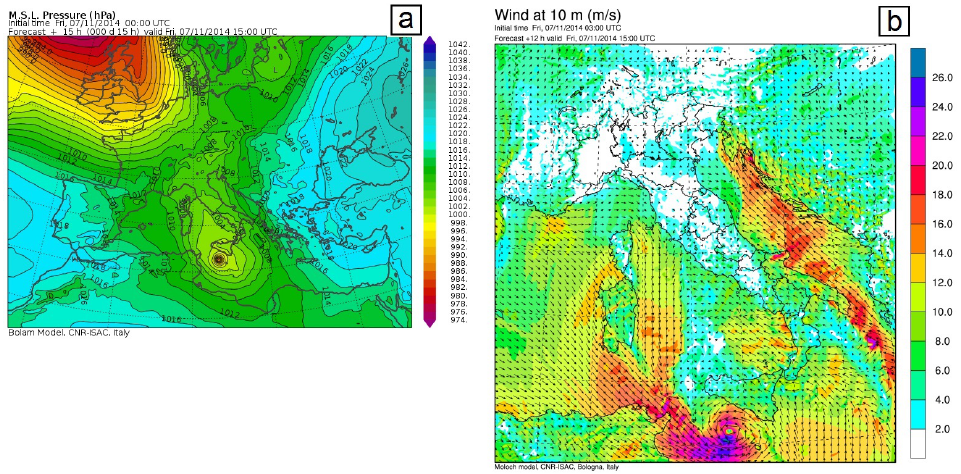
Figure 6. 7 November 2014 15:00 UTC: ( a ) Surface Pressure (hPa) (Bolam simulation); ( b ) Wind (m/s) at 10 m over the north-central Mediterranean (Moloch